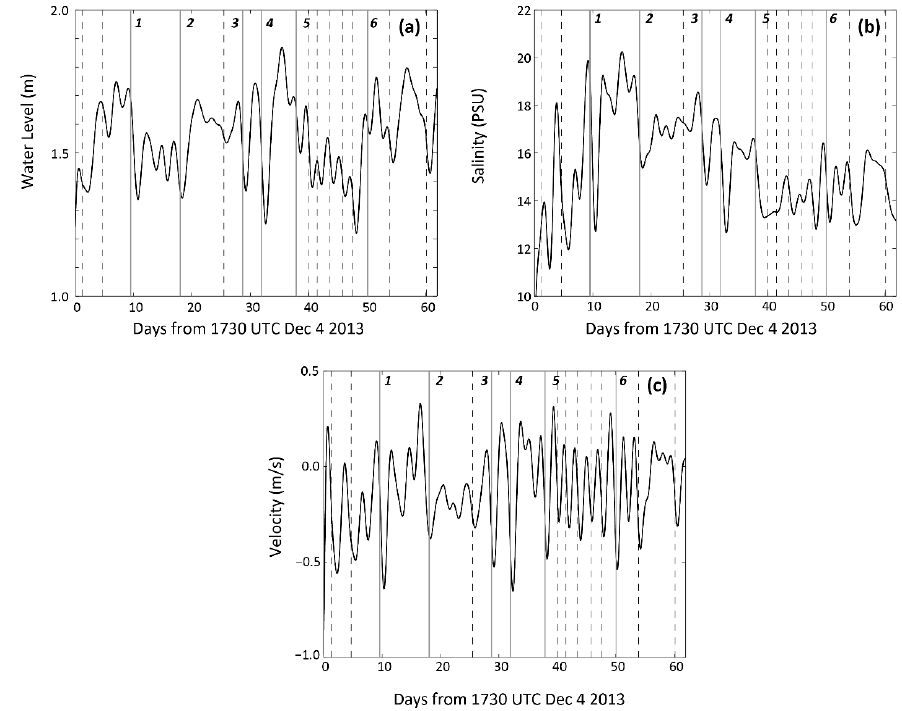
Figure 7. Low-pass filtered ( a ) sensor depth; ( b ) salinity; and ( c ) along channel velocity.The vertical dashed lines are times of atmospheric frontal passages, the solid gray lines are the six selected major fronts.